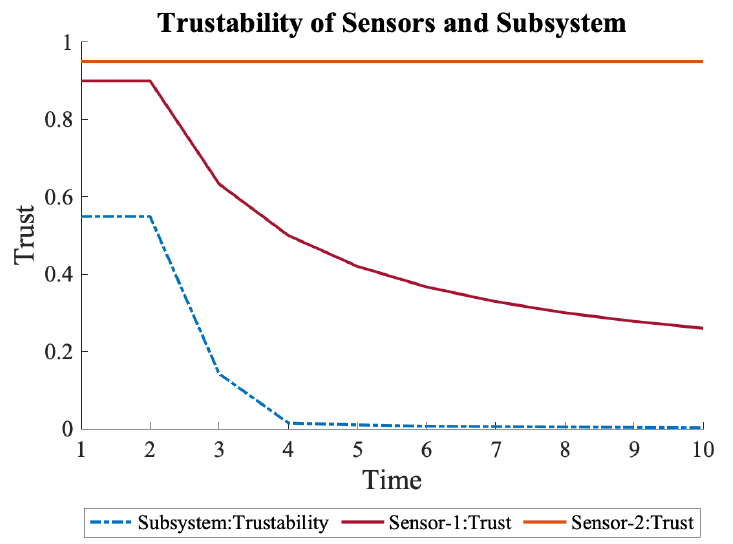
Figure 5. Trustability of System-1 and the sensors. The subsystem is susceptible to any trust fluctuation due to serially connected sensors.